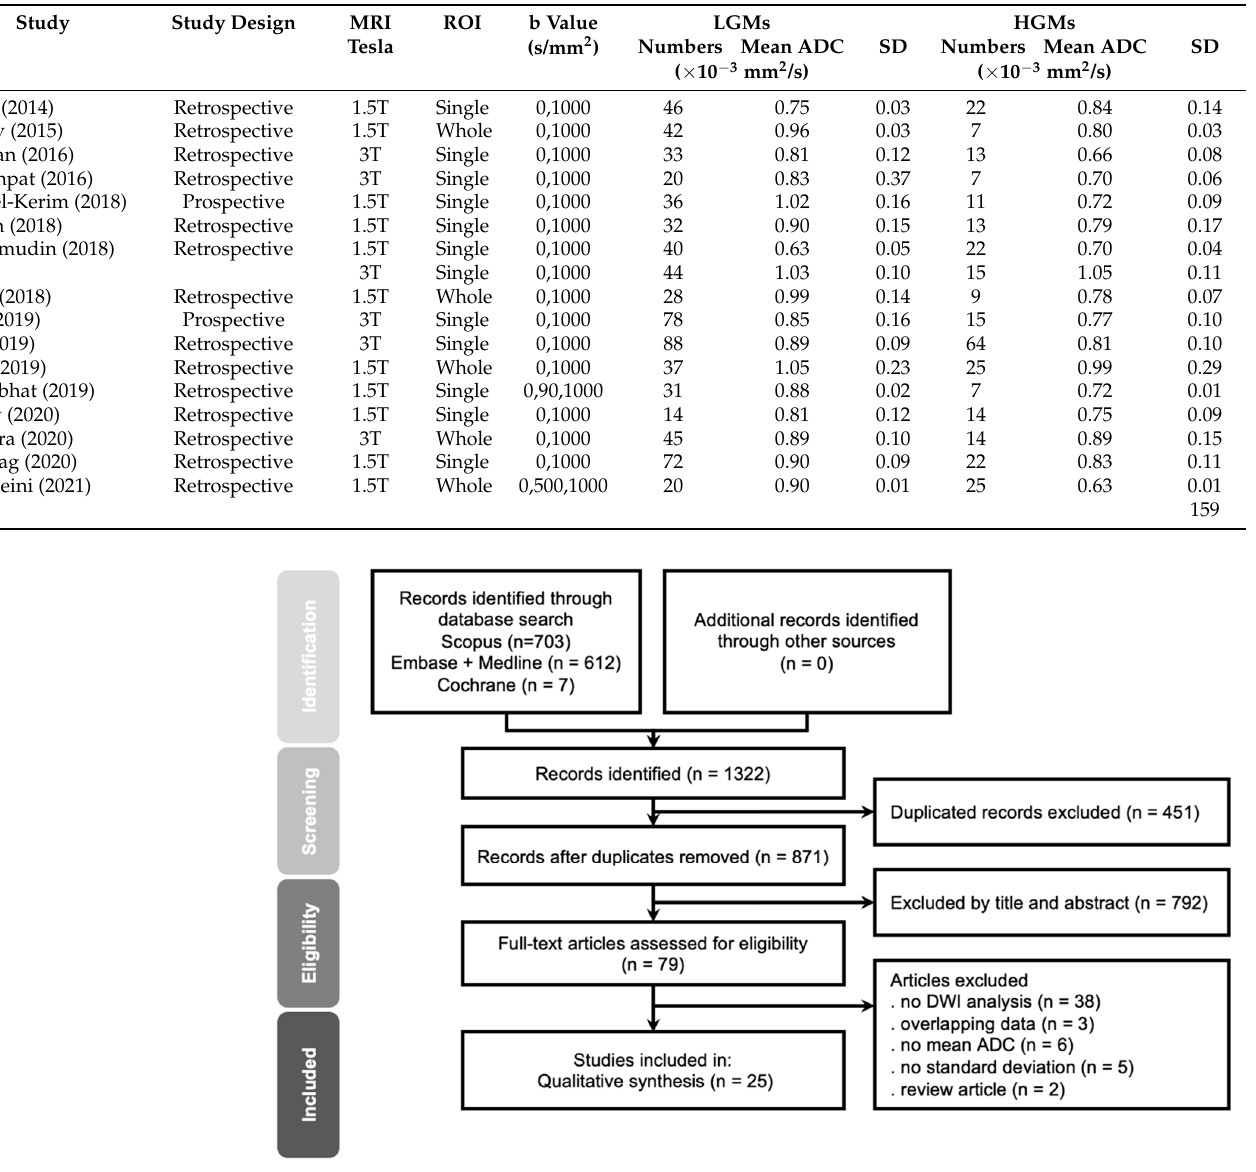
Figure 1. PRISMA flowchart for study selection . Table 1. Baseline characteristics of the 25 studies included in the meta-analysis .